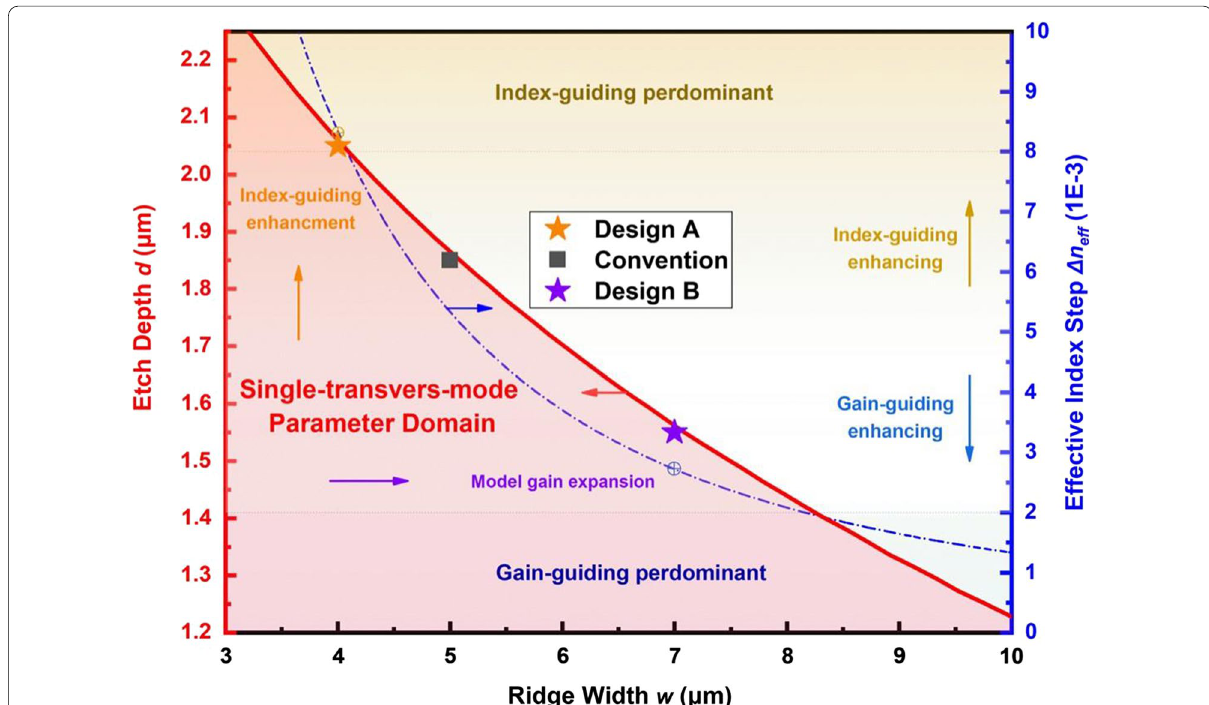
Fig. 2 Two-dimensional waveguide parameter domain that supports the single transverse mode operation with Design A ( w and Design B ( w 7 µ m, d 1.55 µ m), which reflect the two major optimization directions involving index and gain enhancements, respectively. = = The conventional design ( w 5 µ m, d 1.85 µ m) is also = =